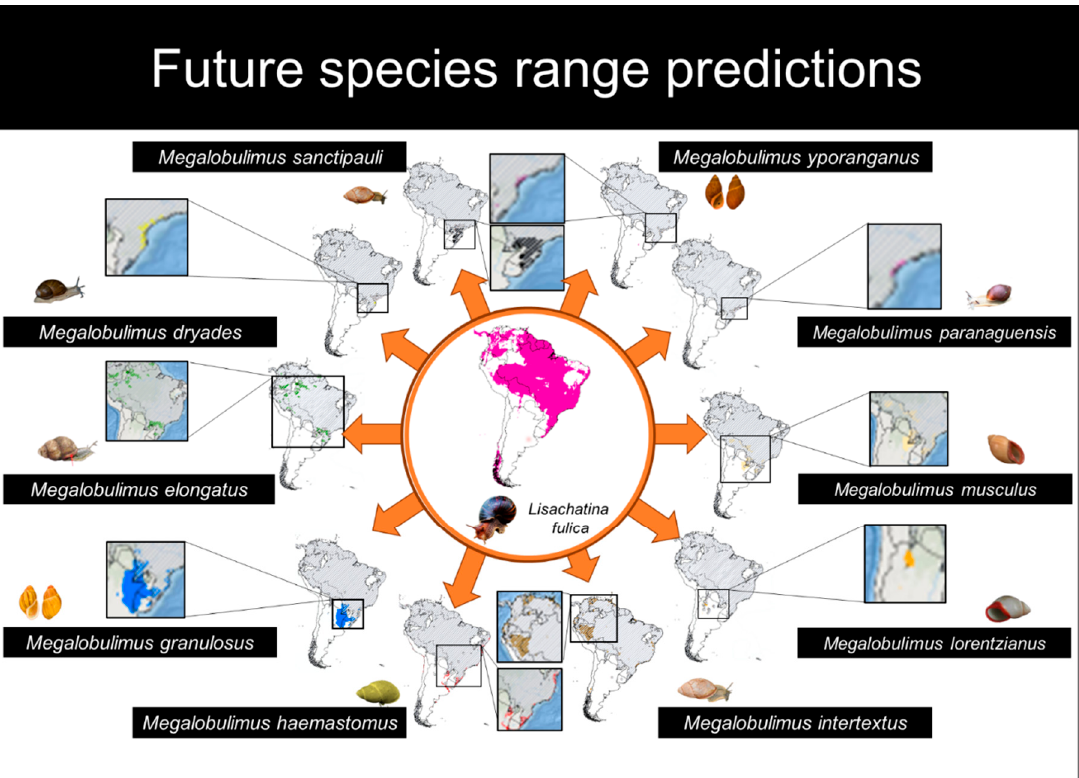
Figure 3. Predicted distribution maps for the future scenario (2040–2060) of the ten species of Megalobulimus and Lissachatina fulica . The native species are represented by the following colors: M. sanctipauli (black), M. dryades (yellow), M. elongatus (green), M. granulosus (blue), M. haemastomus (red), M. intertextus (brown), M. lorentzianus (orange), M. musculus (beige), M. paranaguensis (pink), and M. yporanganus (purple). The lines on the maps for each species correspond to the distribution of L. fulica .